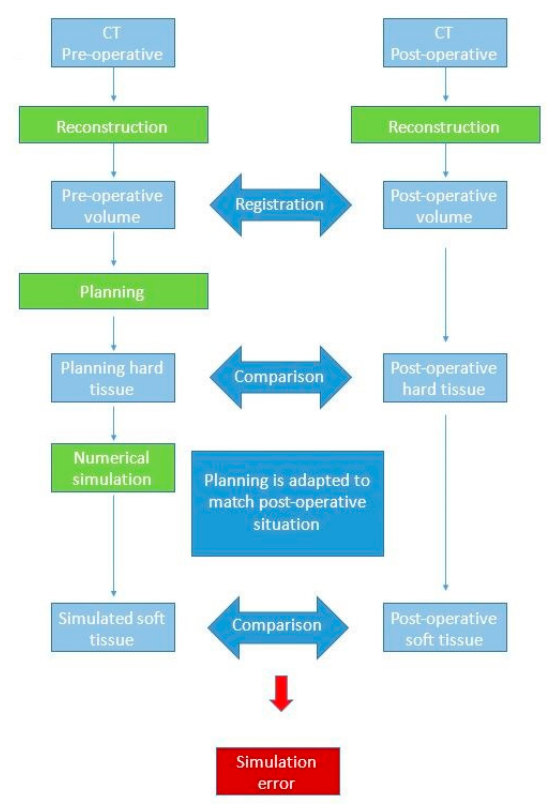
Figure 5. Virtual surgical planning proposed by Marchetti et al. [30].